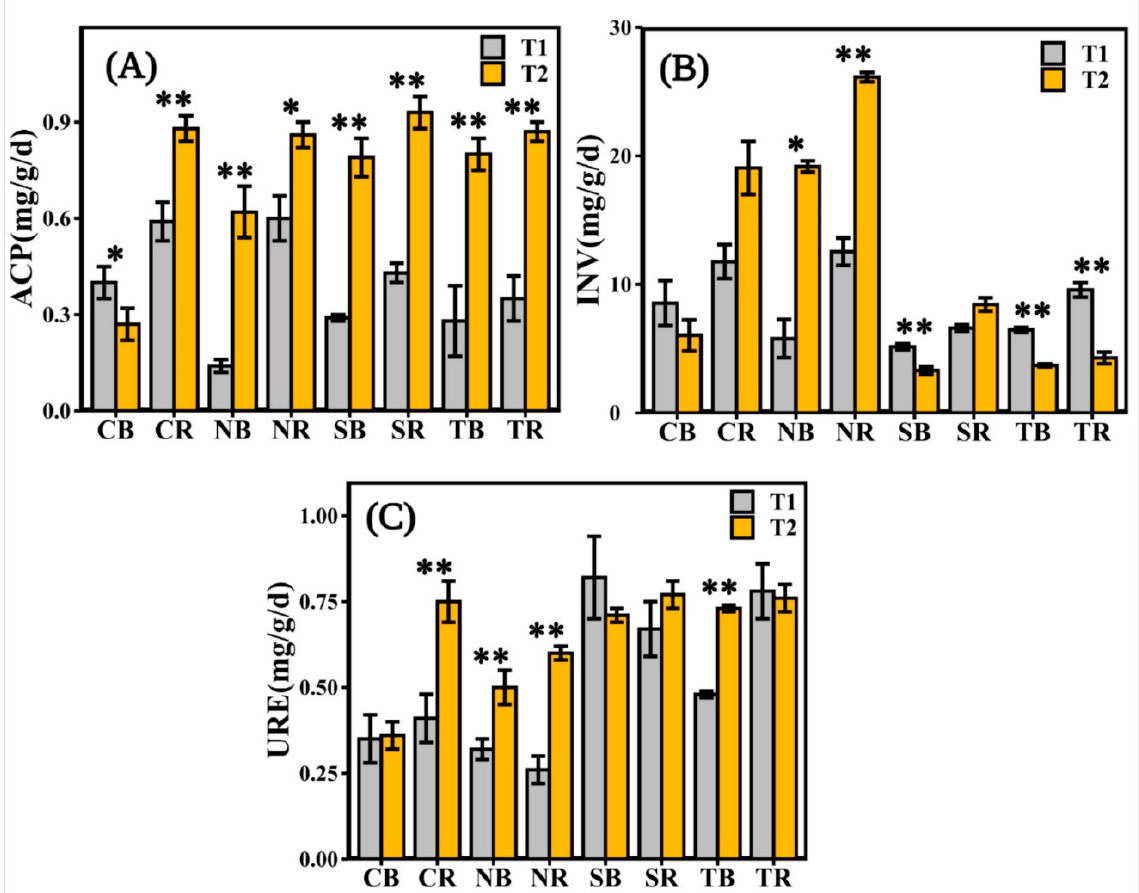
Figure 3. The soil enzyme activities measured in different emergence phases (T1 for early phase and T2 for late phase) within the riparian zones of the Three Gorges Dam Reservoir, China. The values of acid phosphatase (ACP), invertase (INV), and urease (URE) were available from the rhizosphere and bulk soil of selected plants in ( A – C ). Note: bars indicate significant differences at p < 0.01 (**) or p < 0.05 (*) according to the paired t -tests. Abbreviations in the figure define as bulk soil (B), rhizosphere soil (R), Cynodon dactylon (C), Hemarthria altissima (N), Salix matsudana (S), Taxodium distichum (T).